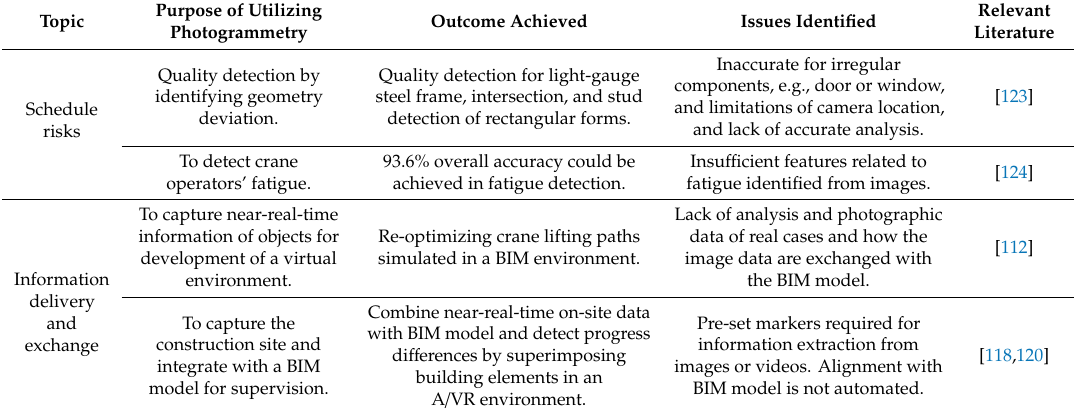
Table 12. Research topics, purpose of photogrammetry adoption, and outcomes achieved in previous